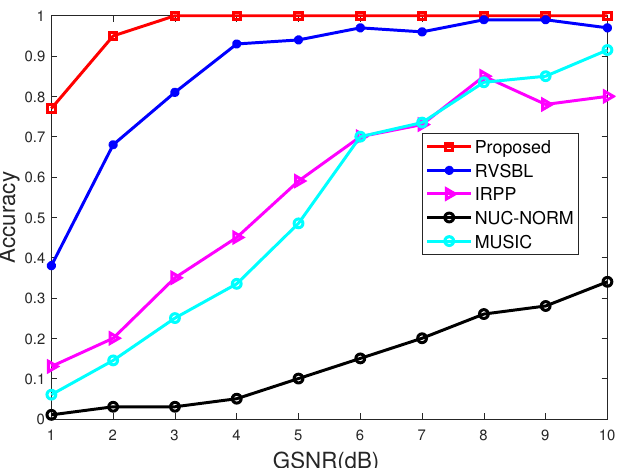
Figure 1. Accuracy with different